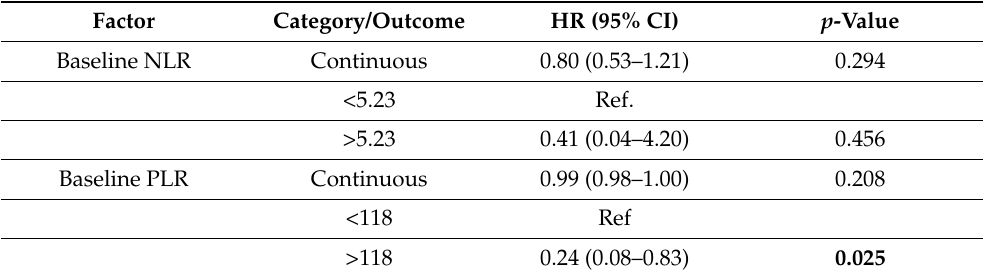
Table 12. Multivariable analysis of association between pre-operative NLR and PLR with a larger than 25% drop in eGFR